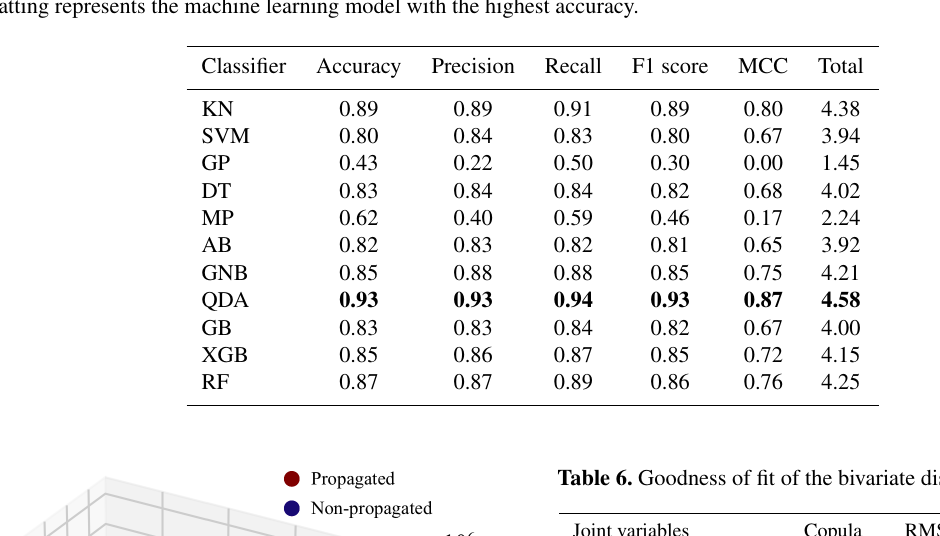
Table 4. Estimations of 11 machine learning models in identifying the potential of meteorological drought to trigger ecological drought. Bold formatting represents the machine learning model with the highest accuracy.